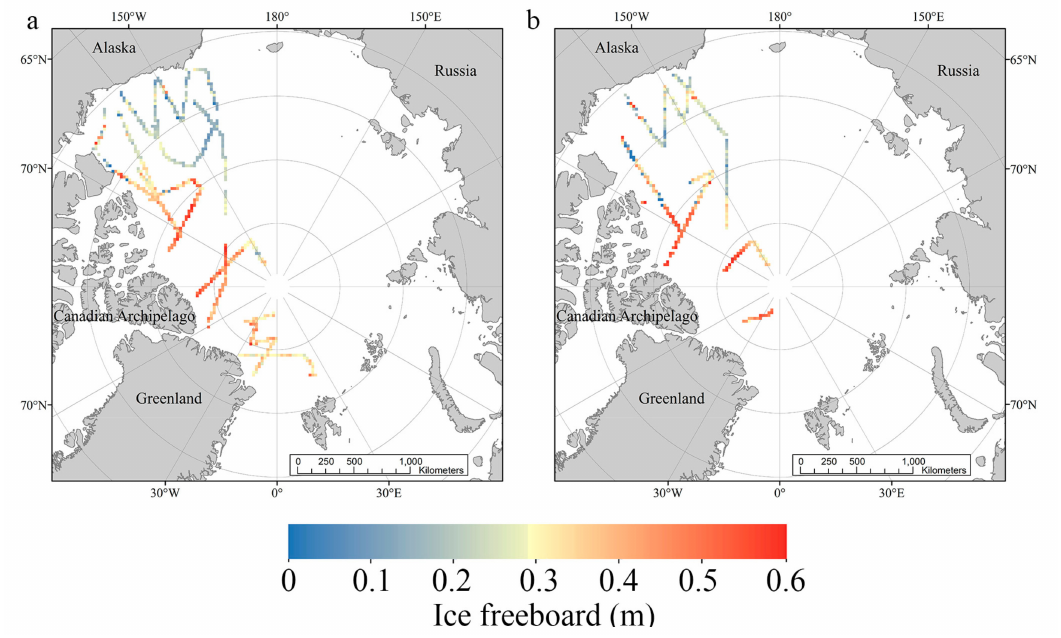
Figure 1. Map of OIB freeboard for March 2015 ( a ), April 2016 ( b